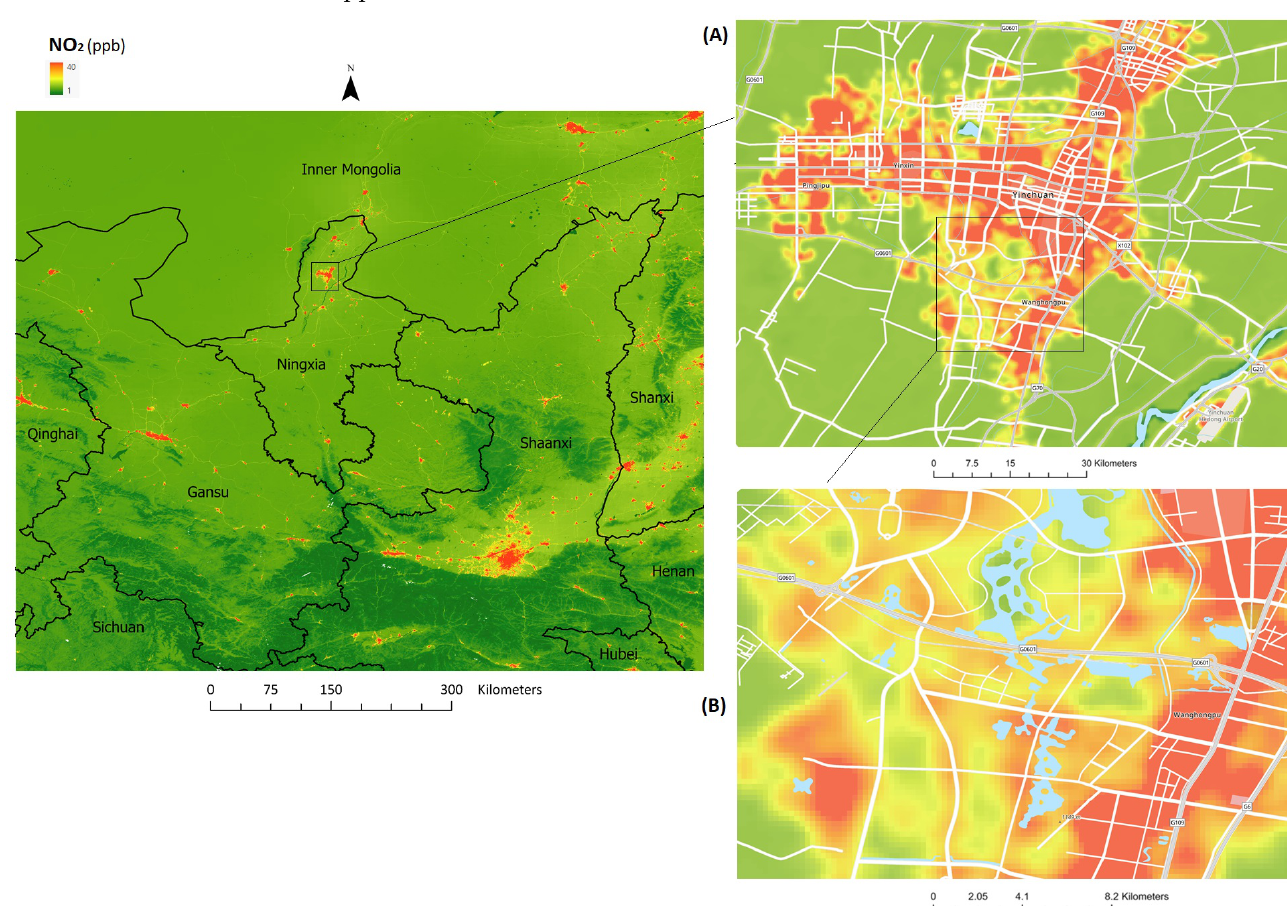
Figure 2. Mean annual NO 2 model predictions for Ningxia and surroundings (2019), gridded at 100 m (black polygon lines represent provincial level divisions in the region). Inset ( A ) is of Yinchuan (2.3 million population), capital of Ningxia Province (7.2 million population). Inset ( B ) highlights local variability in NO 2 concentrations in urban locations in Yinchuan (Estimated range: 12–38 ppb) (white polylines in insets ( A , B ) represent major roads). Inset A of Figure 2 focuses on Yinchuan (capital of NHAR; population: 2.3 million).